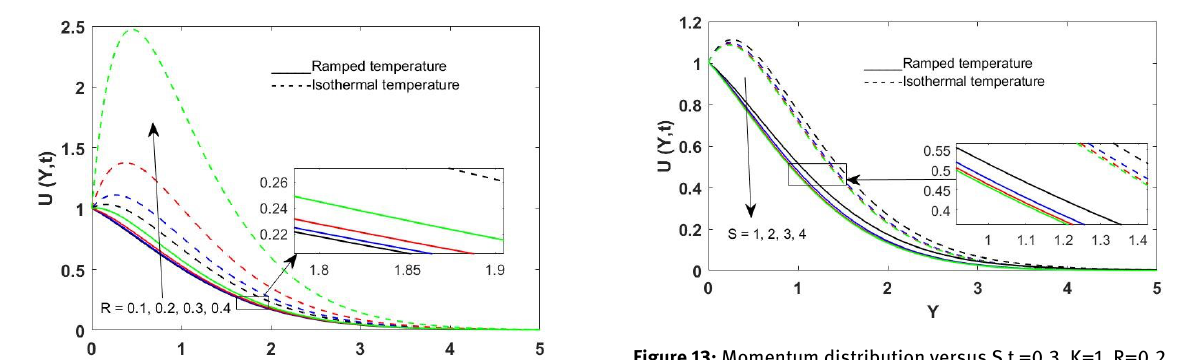
Figure 13: Momentum distribution versus S t =0.3, K=1, R=0.2,